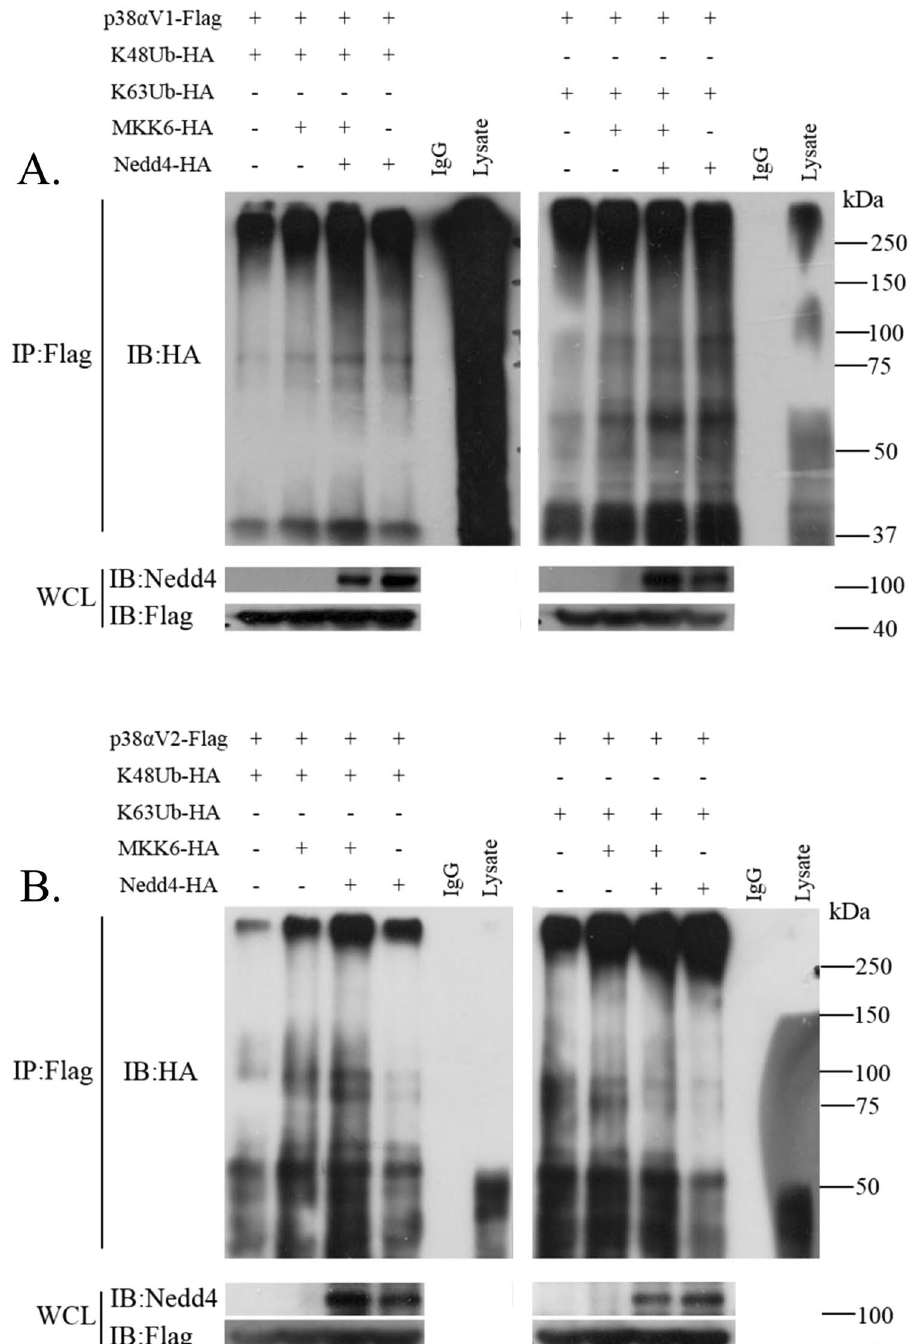
Figure 6. Phosphorylation promotes Nedd4 mediated K48-linked rather than K63-linked polyubiquitination of p38 α V1 and p38 α V2. Immunoblot analysis of anti-Flag immunoprecipitates of lysates of 293T cells co- transfected with various molecules (above lanes), probed with anti-HA ( A , B ). For whole cell lysates, p38 α V1 and p38 α V2 were probed with anti-Flag, and Nedd4 was probed with